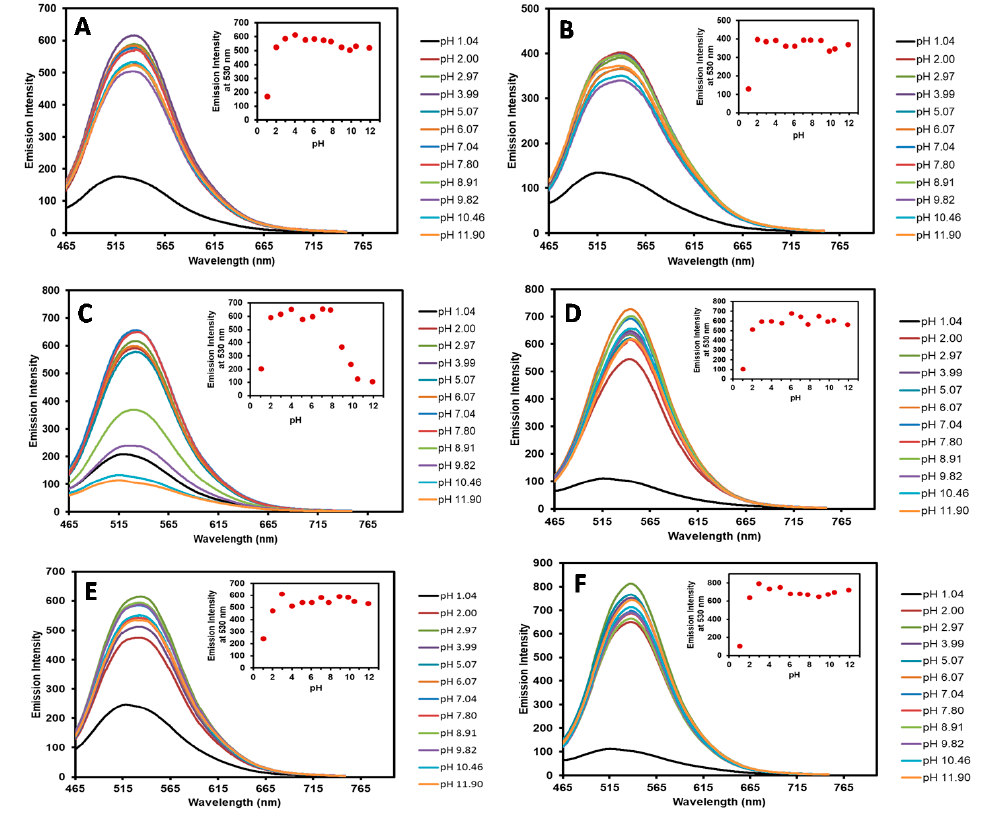
Figure Figure 3. Fluorescence spectra of 3a ( A ), 3b ( B ), 3c ( C ), 3d ( D ), 3e ( E ), and 3f ( F ) in pH 1.04–11.90 buffers.